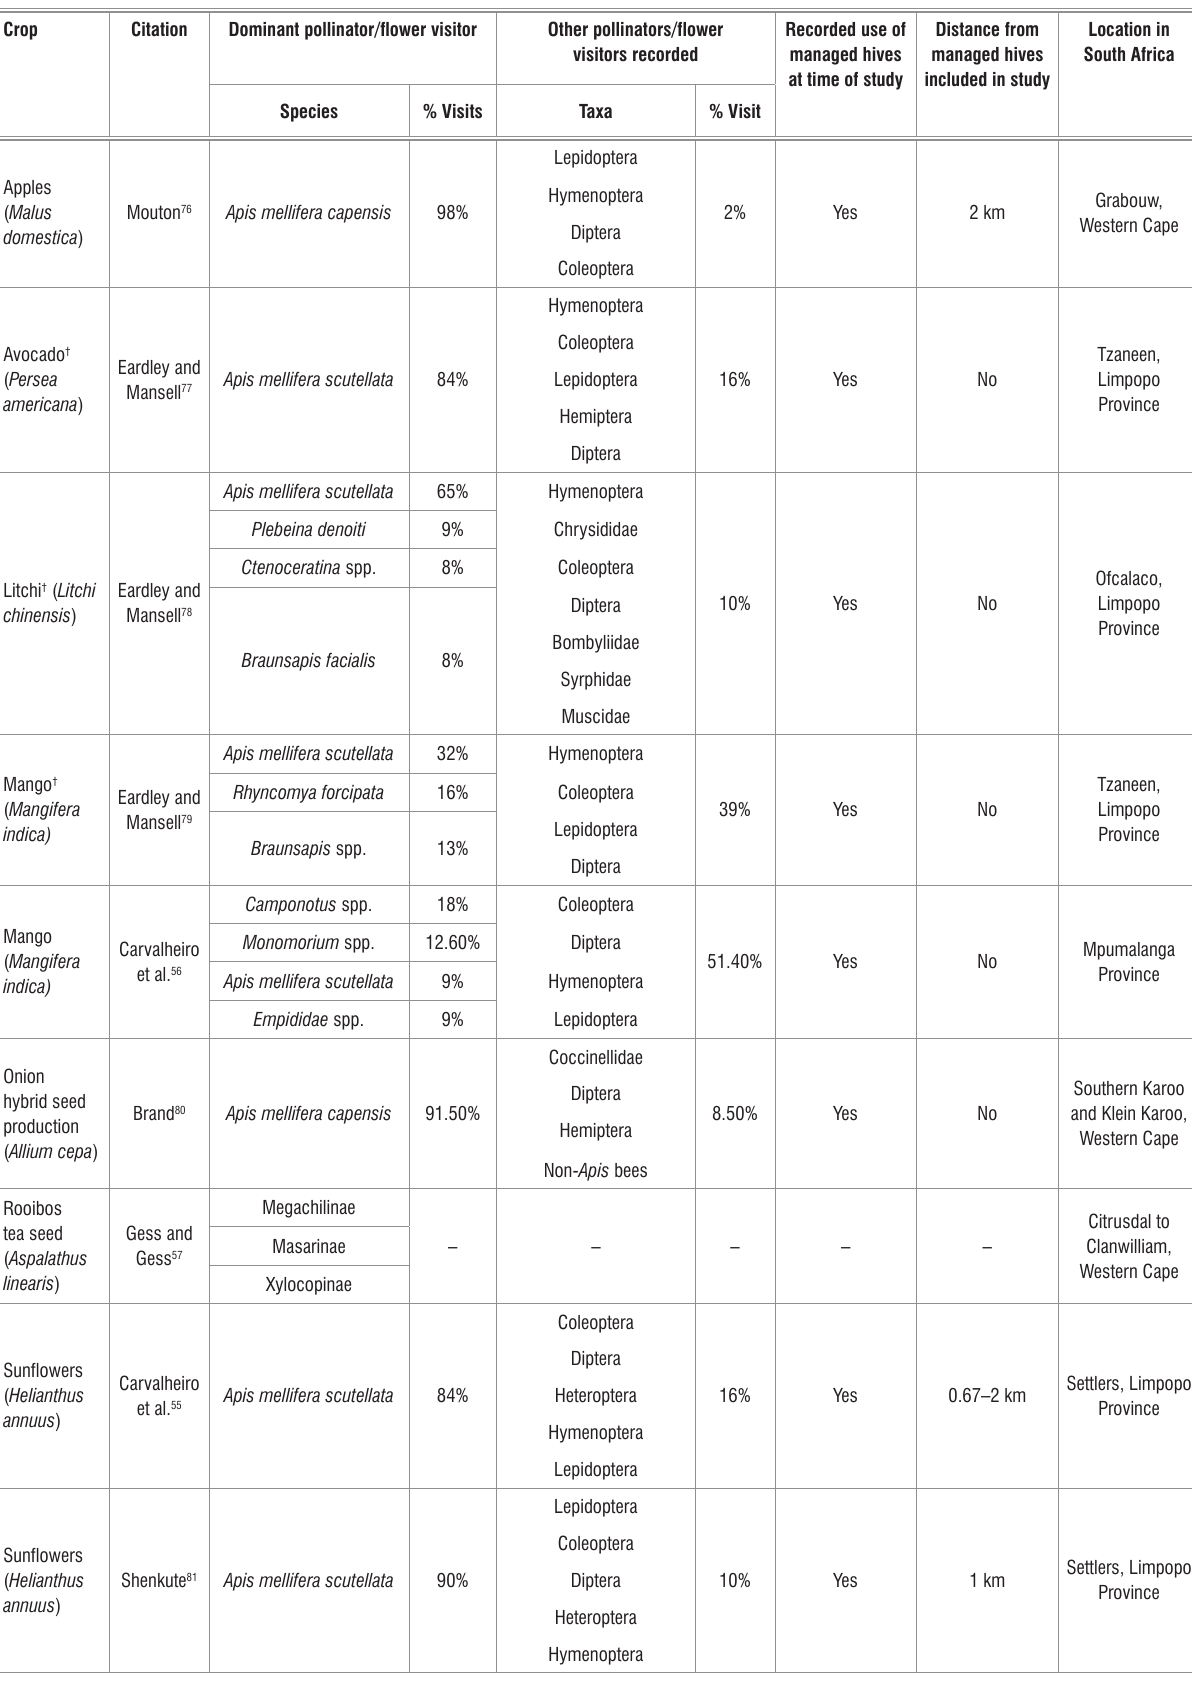
Table 1: A summary of research assessing the importance of different pollinator assemblages as a basis for services to crop production in South Africa Crop Citation Dominant pollinator/flower